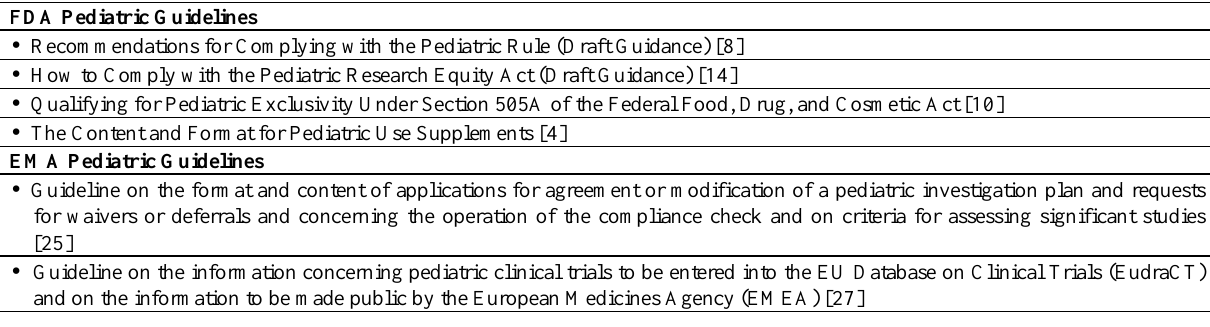
Table 4. Procedural guidelines for pediatric drug development.